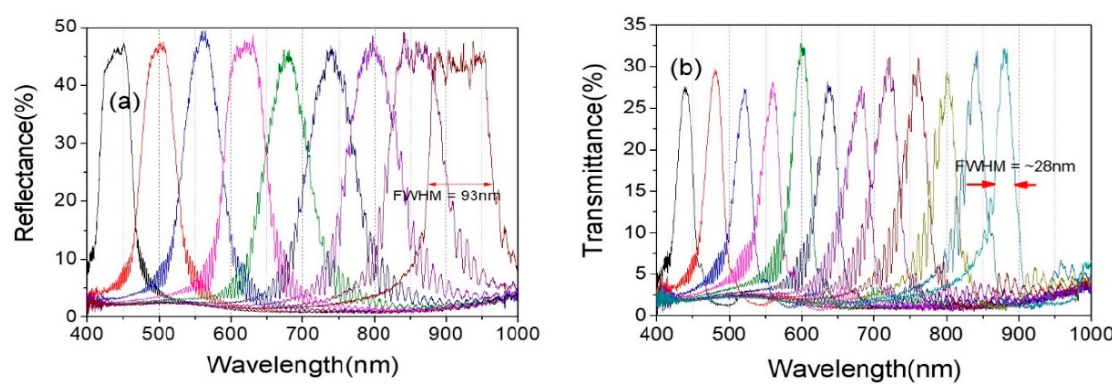
Figure 8. Original PBG bandwidth of the R-PCLC1 cell ( a ) and reduced PBG bandwidth spectra ( b ). Data are shown in a low density to distinguish one by one easily.